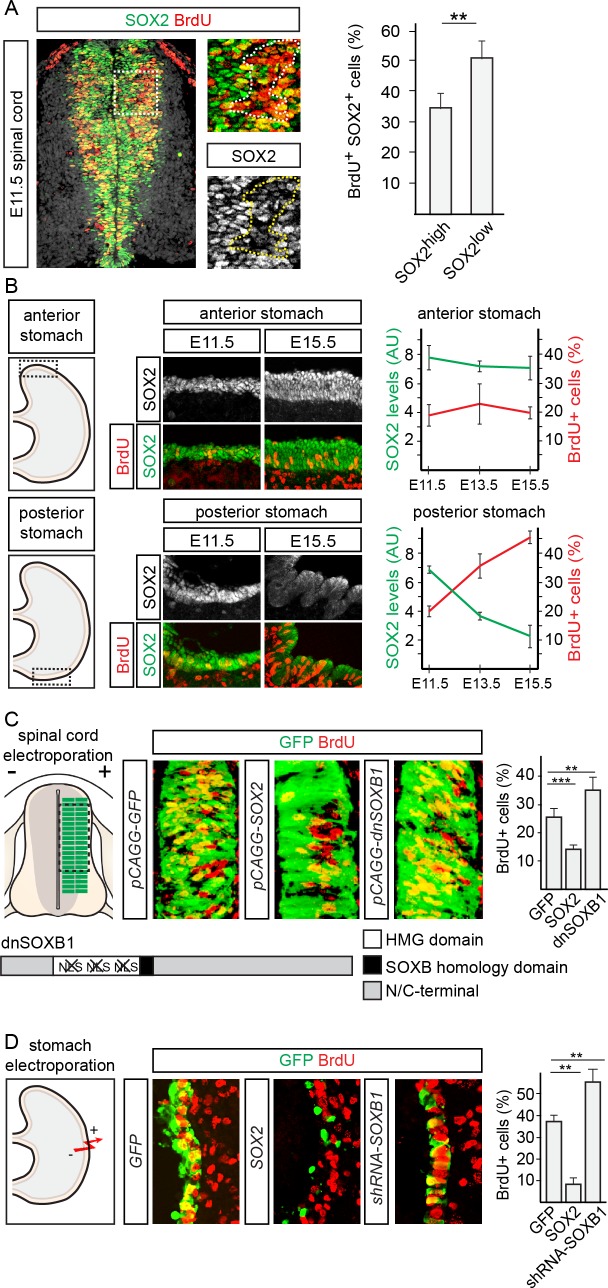
SOX2 represses proliferation in the developing spinal cord and stomach.(A) Percentage of cells expressing high or low levels of SOX2 labelled by a one hour pulse of BrdU in the E11.5 mouse spinal cord. Dotted lines in insets surround area of greatest BrdU incorporation. (B) Average background normalized SOX2 expression level and percentage of cells labelled by a one hour pulse of BrdU in the E11.5, E13.5 and E15.5 anterior and posterior stomach. (C) Percentage of electroporated cells in the chick spinal cord labelled by a 30 minute pulse of BrdU following misexpression of GFP, SOX2 or dnSOXB1. (D) Percentage of electroporated cells in E13.5 stomach explants labelled by a 30 minute pulse of BrdU following overexpression of GFP, SOX2 or dnSOXB1. All error bars represent standard deviations between experiments and p-values are calculated with two sided, unpaired t-tests (* = p<0.05, ** = p<0.01, *** = p<0.001).